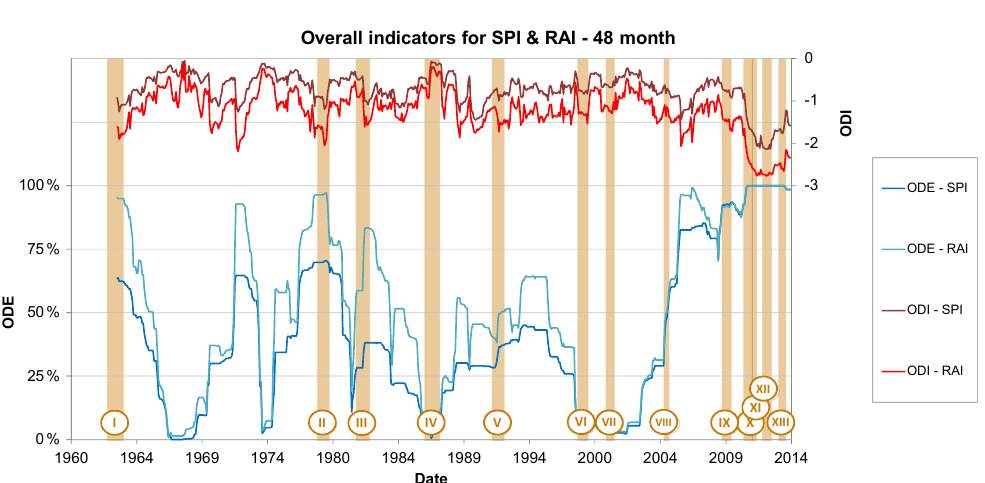
Figure A11. ODE and ODI values using the 48-month timescales of SPI and RAI indices, compared with the 13 detected historical droughts (in orange).